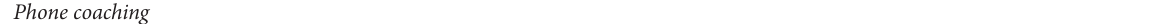
Table 3: Participant feedback on